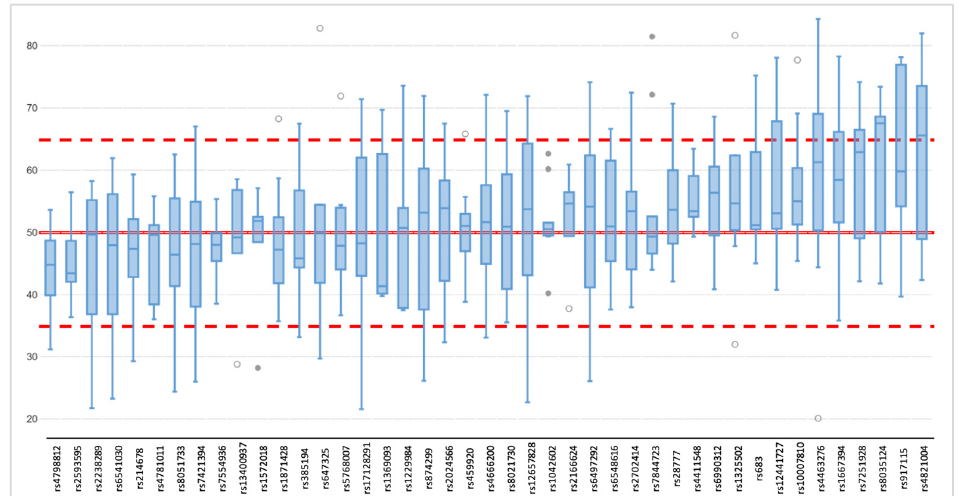
Figure 2. The minimal coverage of at least one read was observed for over 99% of all amplicons across the amplified libraries (AMP), whereas for unamplified libraries (NA), the value was 96%. At least 20 reads were reached by little less, namely 94% of the AMP libraries, while across the NA libraries, it was noticeably less, namely 70% of the amplicons. Over 75% of the amplicons across the AMP libraries had coverage of at least 100 reads, but less than 20% of the NA libraries reached the coverage. The 500X coverage was observed for almost 20% of the amplified libraries and 1% of the NA libraries.